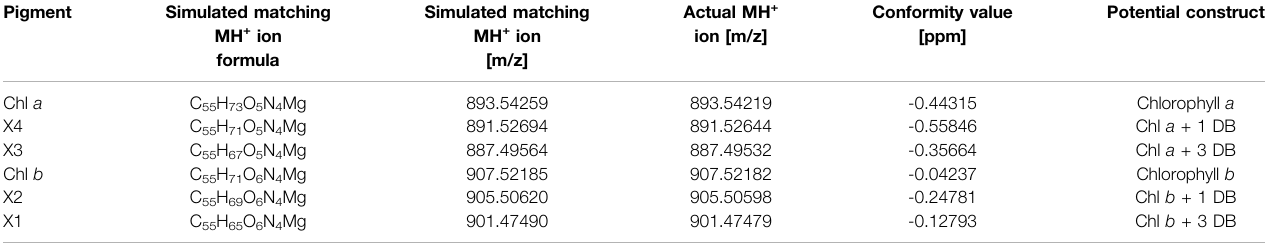
TABLE 4 | Identi fi cation of chlorophylls by high resolution high pressure liquid chromatography-mass spectrometry (HPLC-MS) analysis of chlorophyll (Chl) a and b and unknown pigments X1-X4. Pigment